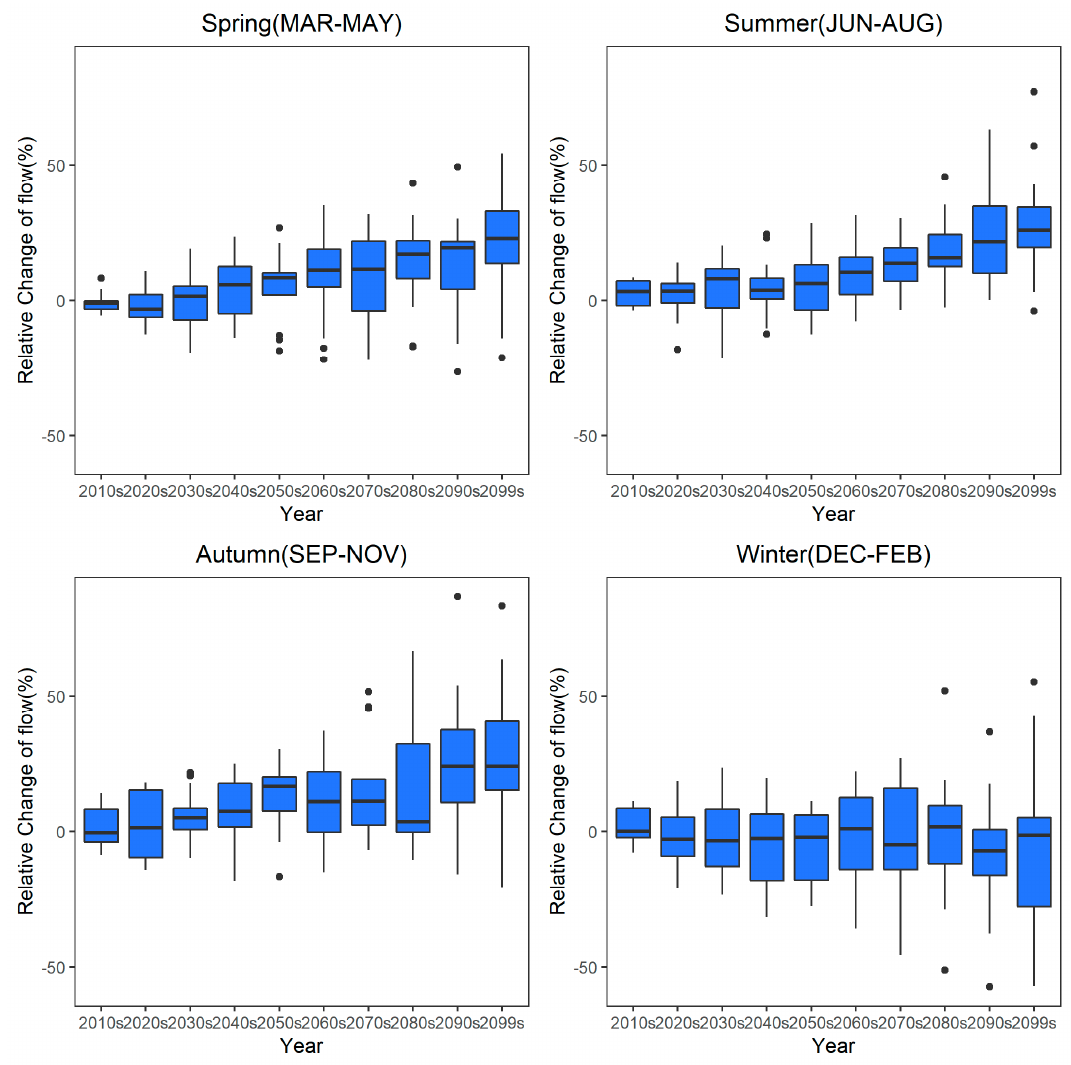
Figure 7. Relative change (%) of the 30-year moving average seasonal flow compared with the reference period (1976–2005) for RCP 8.5 using 13 GCMs in South Korea. The values were calculated by first converting the daily flow data into seasonal flow data. Next, the relative change of the 30-year moving average seasonal flow for 13 GCMs was calculated and is shown as a box plot.